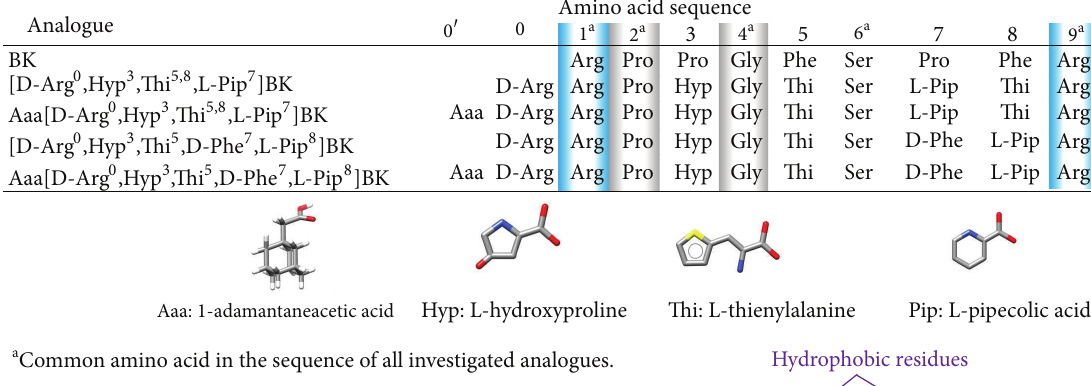
Table 1: Amino acid sequence of bradykinin (BK) and its specifically mutated analogues investigated in this work.